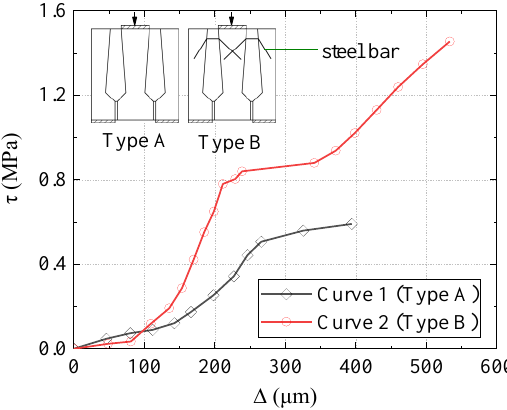
Figure 12. τ - ∆ plots (data from Ye et al. [28]).